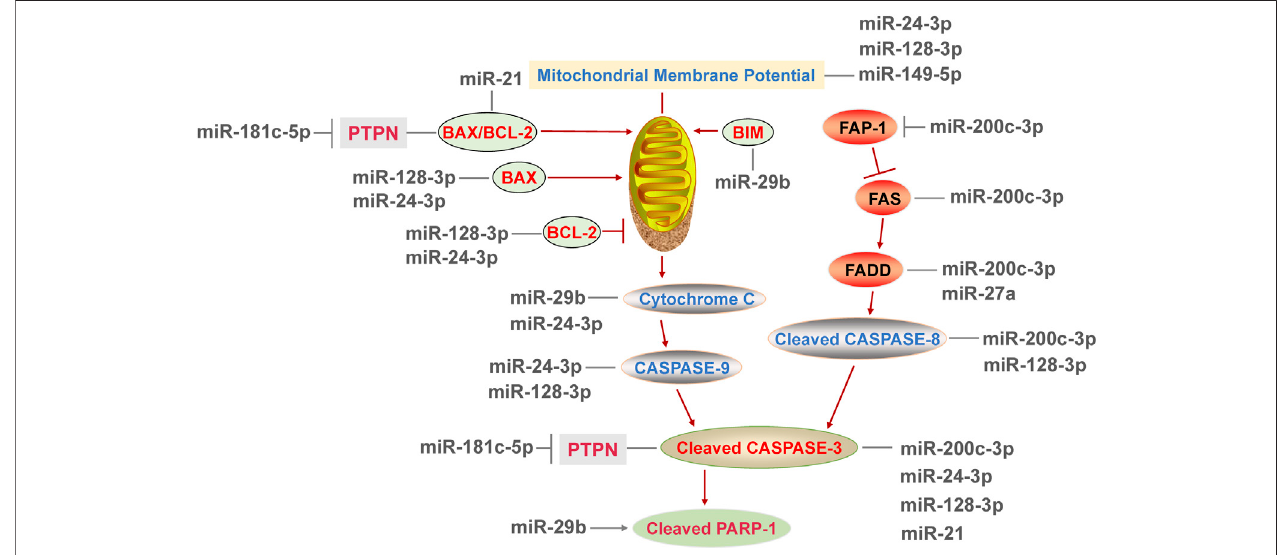
FIGURE 4 | MicroRNAs regulate the DNA damage response by affecting the participators of both mitochondria-mediated intrinsic apoptosis pathway and death receptor-mediated extrinsic apoptosis pathway.